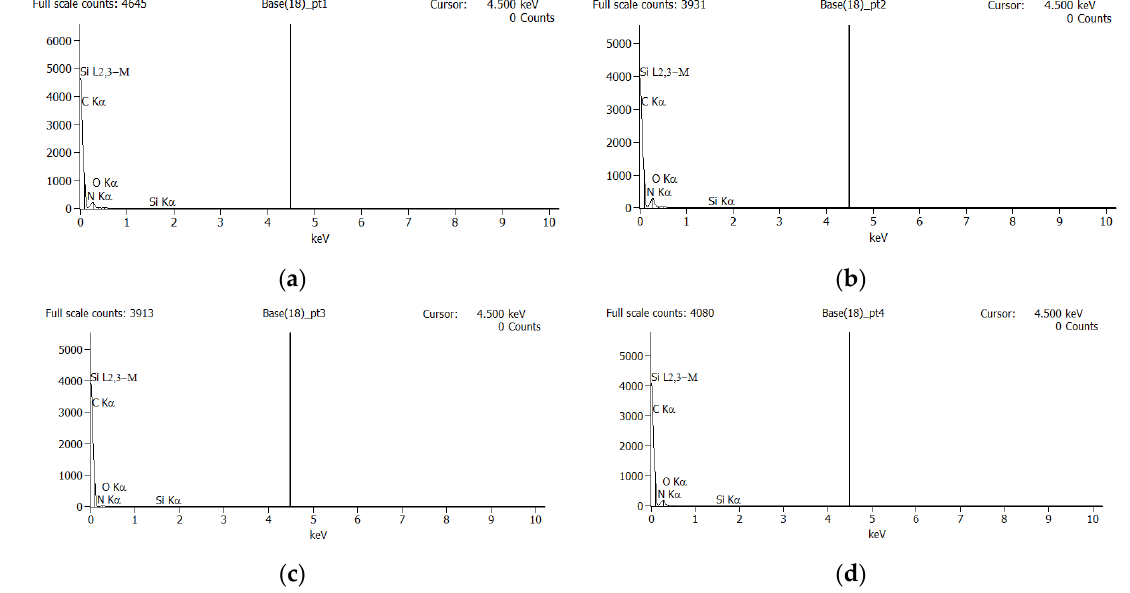
Figure 10. EDX analysis for the four points within the case (a) from Figure 9: ( a ) Point 1; ( b ) Point 2; ( c ) Point 3; (d ) Point 4. Table 3. EDX results for the first area from Figure 9.